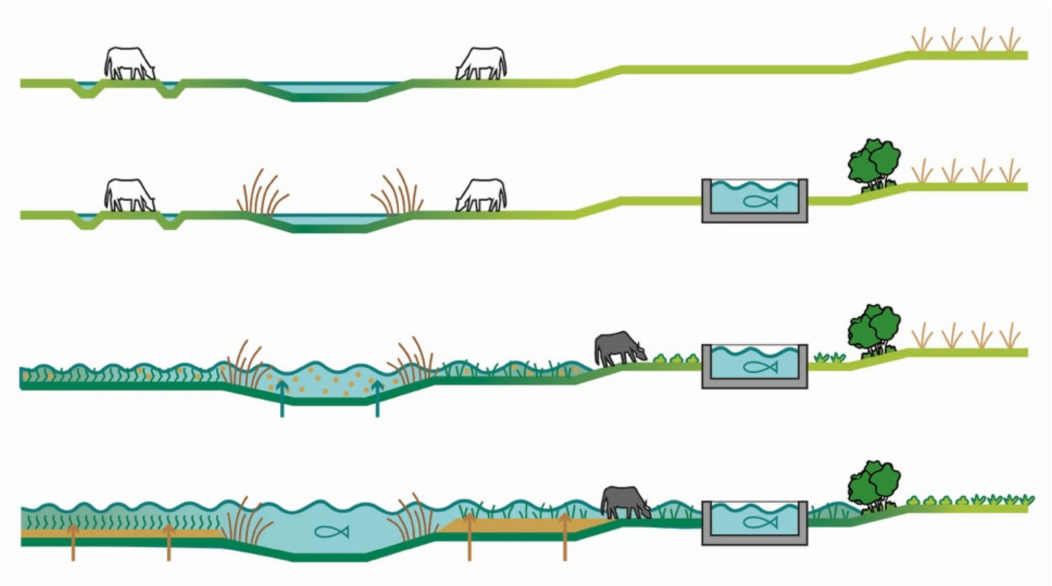
Figure 18. Salinification of the food